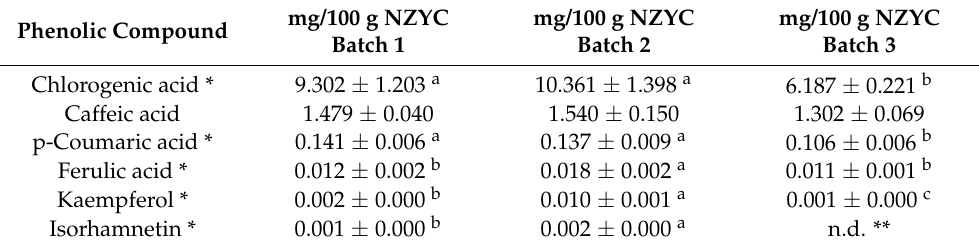
Table 3. Phenolic profile of NZYC as determined by liquid chromatography—mass spectrometry ( n = 9).